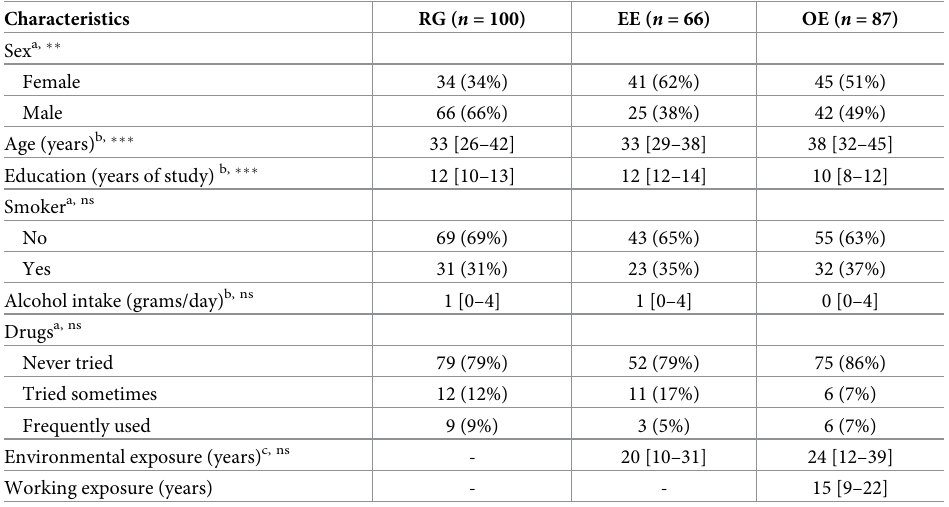
Table 1. Socio-demographic characteristics of the studied groups.